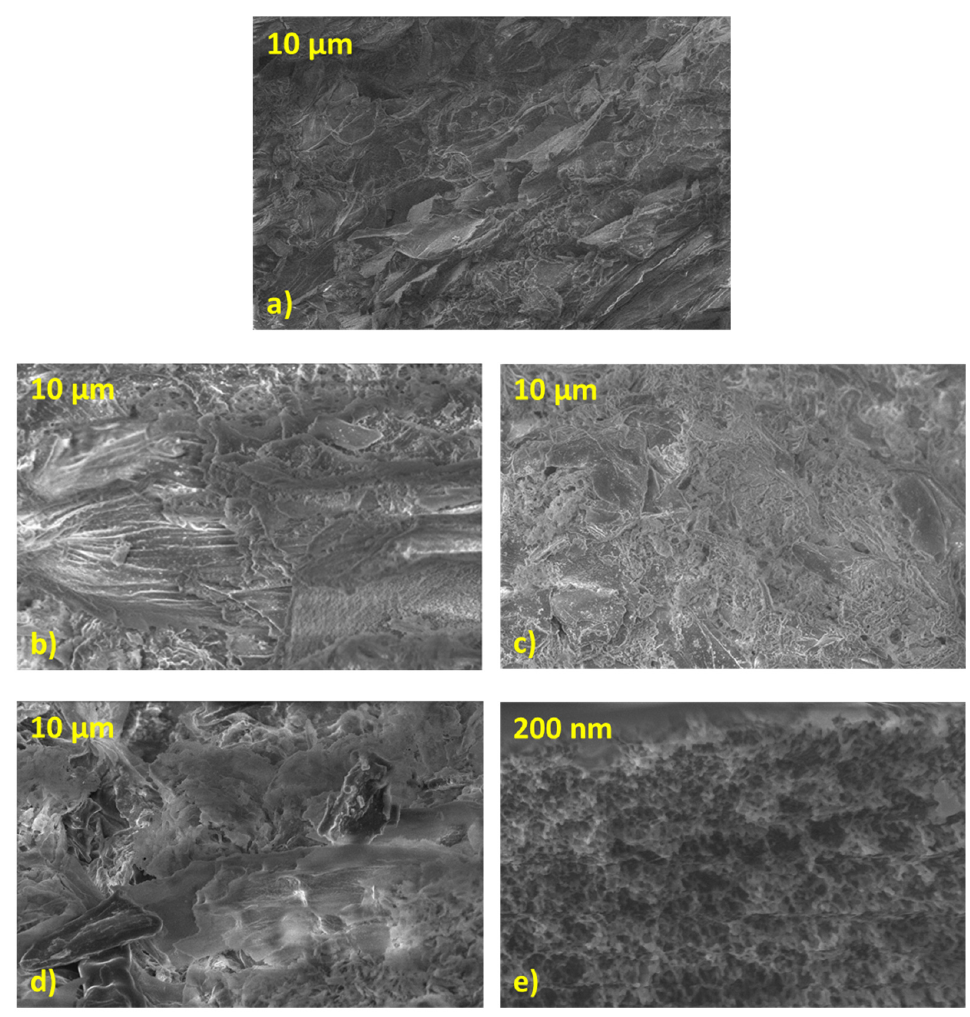
Figure 5. SEM images on SB ( a ), HC-200 ( b ), HC-240 ( c ) and HC-280 ( d , e ). The spruce bark had a fibrous structure with high length-to-diameter ratios, that was characteristic for lignocellulosic biomass [44]. The hydrochar obtained from spruce bark at 280 °C had a bark-like skeleton, keeping approximately the same anatomical structure similar to the feedstock. This aspect could confirm that during the hydrothermal conver- sion (up to 280 °C) the spruce bark did not suffer a complete degradation. For lower